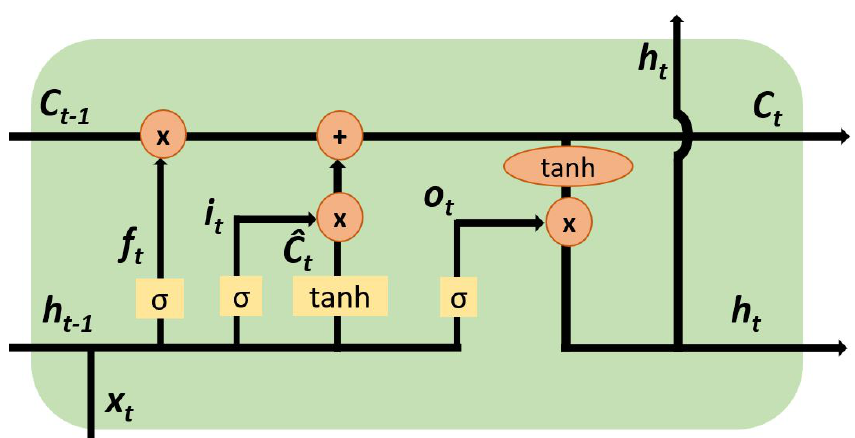
Figure 5. LSTM framework displaying hidden state of the time